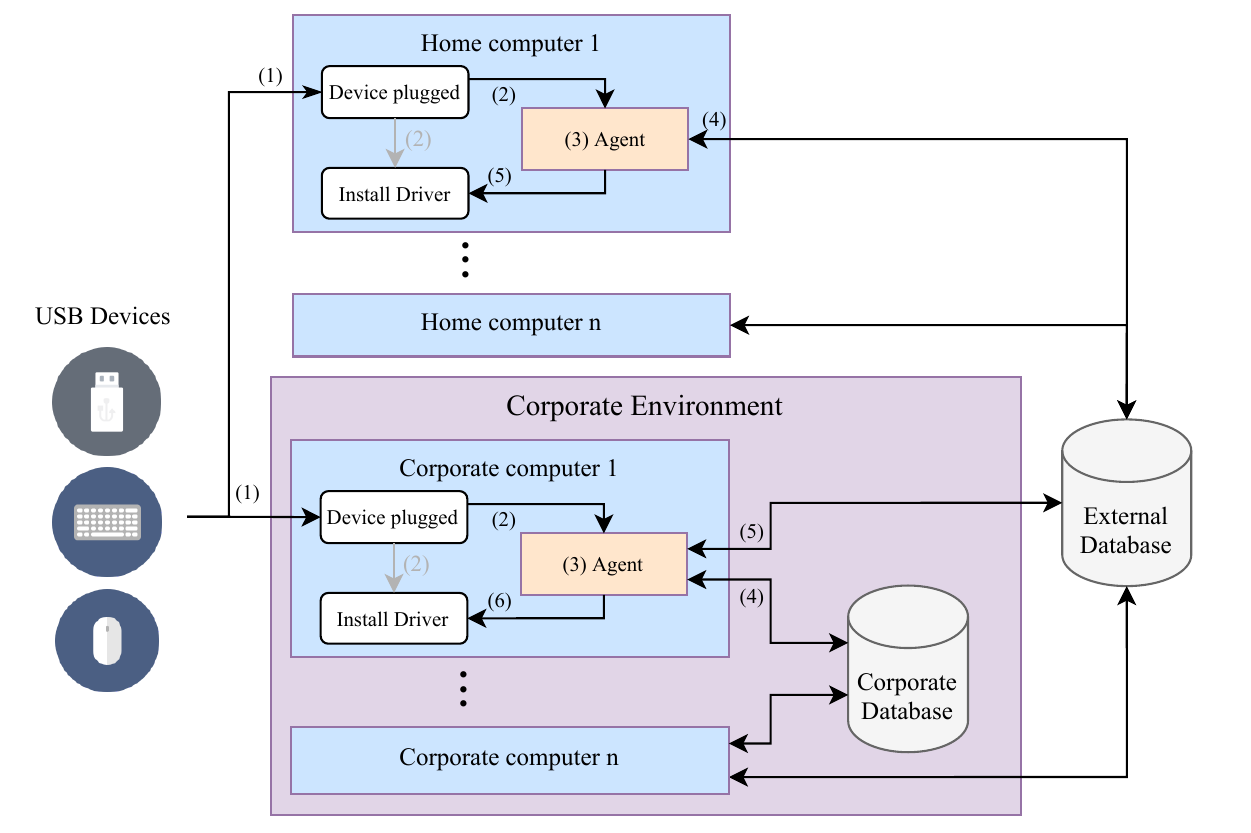
Figure 1. A basic scheme of the system distributed